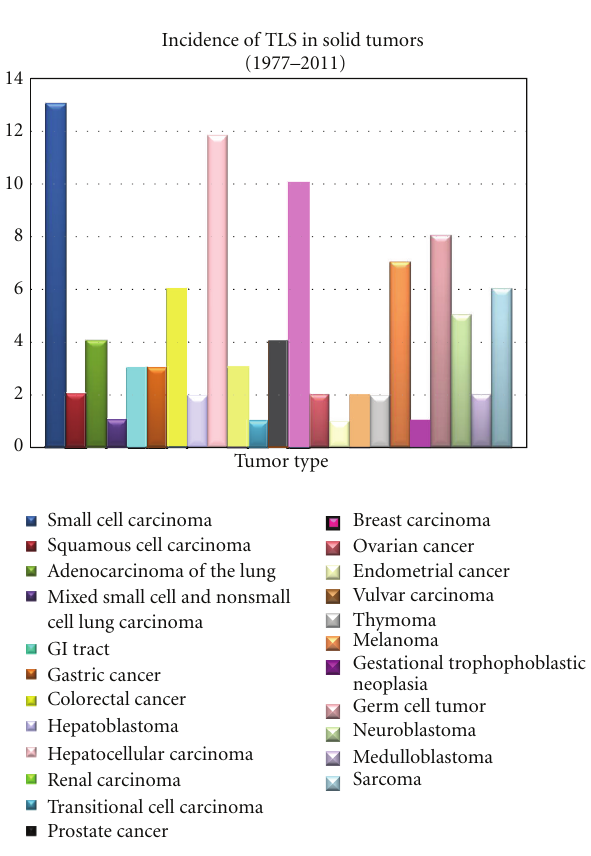
Figure 2: Reported cases of tumor lysis syndrome in solid tumors.